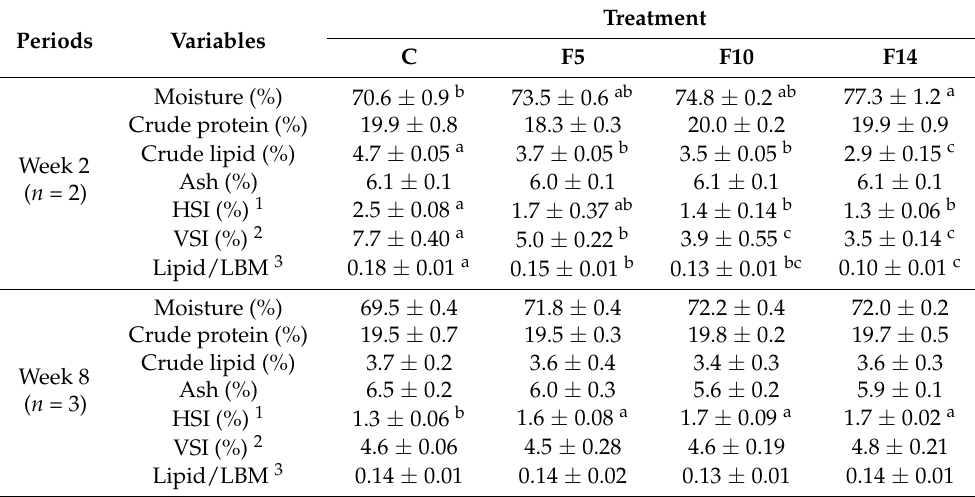
Table 2. Whole-body proximate composition (%, wet weight basis), hepatosomatic index (HSI), and viscerasomatic index (VSI) of juvenile leopard mandarin fish ( Siniperca scherzeri ) at the end of week 2 and week 8 in four different feeding groups